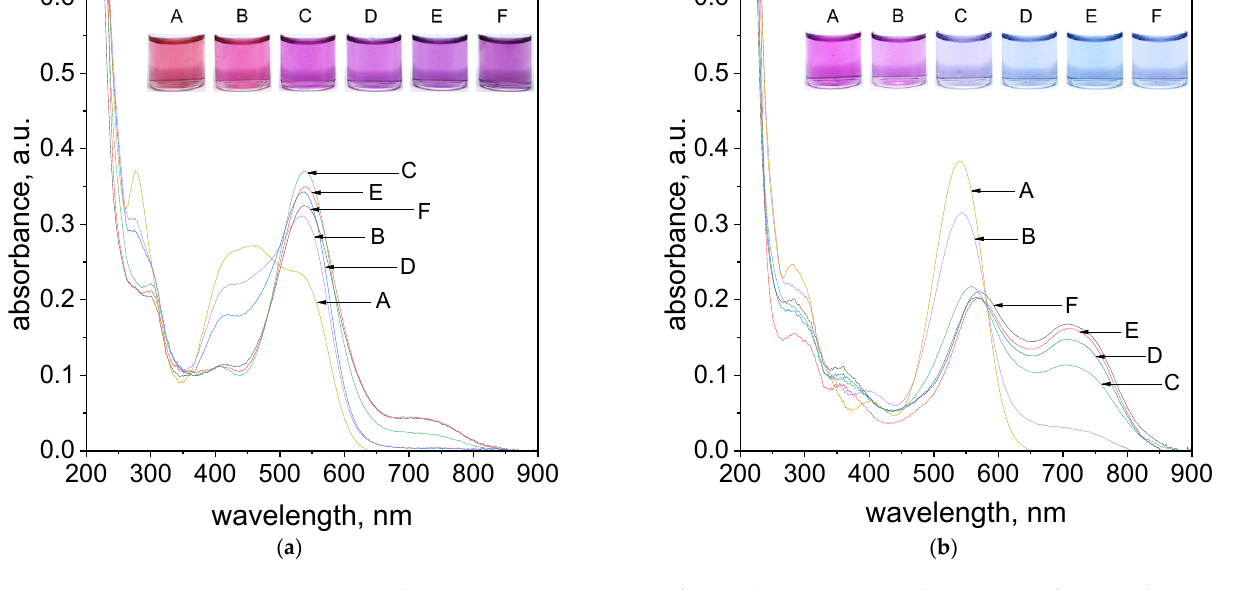
Figure 7. The UV–Vis spectra coming from solution contains the mixture of tropaeolin OO with Pd(II) and different concentrations of Cl − , A: 0.1 mol/dm 3 , B: 0.05 mol/dm 3 , C: 0.01 mol/dm 3 , D: 0.005 mol/dm 3 , E: 0.001 mol/dm 3 , F: 0.0005 mol/dm 3 after 1 h ( a ), 24 h ( b ). Conditions: volumetric ratio: 2.5 mL Pd(II):1.5 mL TR, the value of concentration of Pd(II) ions after mixing with tropaeolin TR = 1.875 × 10 − 5 mol/dm 3 , Pd(II) = 3.125 × 10 − 5 mol/dm 3 , pH = 4.10, temperature 50 °C.